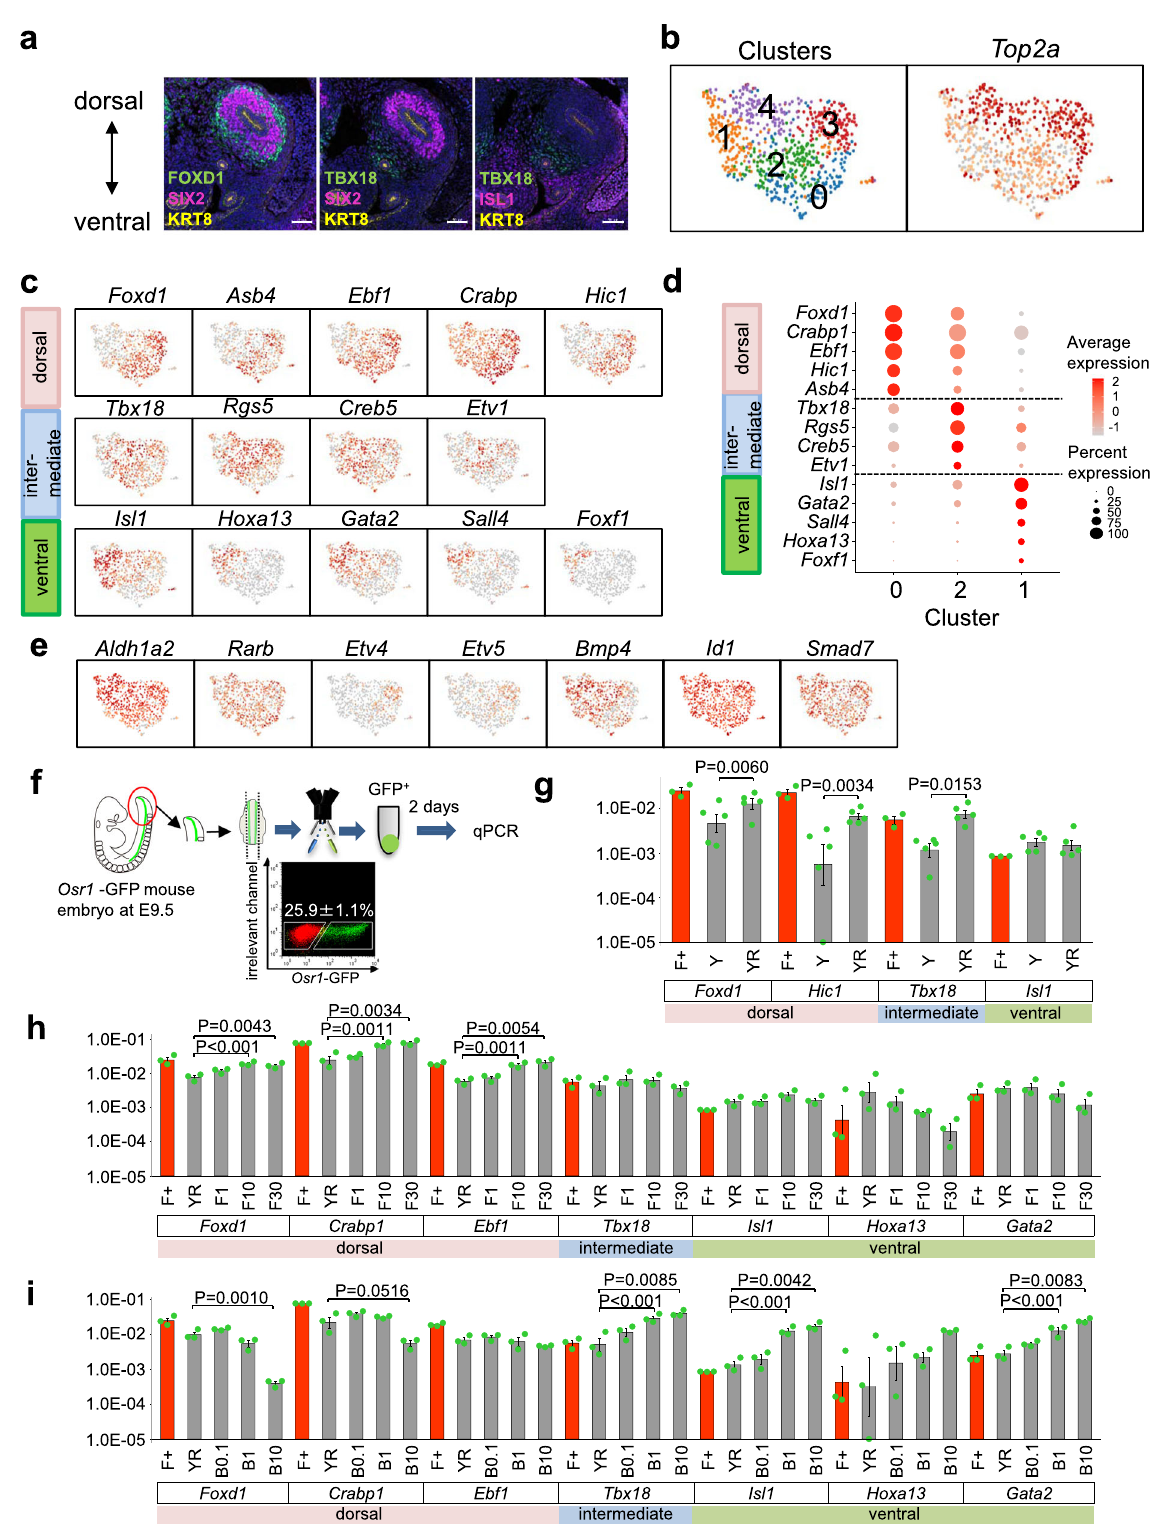
expression of signaling ligands/synthesis enzymes (Fig. 1e and Supplementary Fig. 1e) was consistent with previous in vivo studies, including FGF20 expression in NPs, FGF9 in NPs and